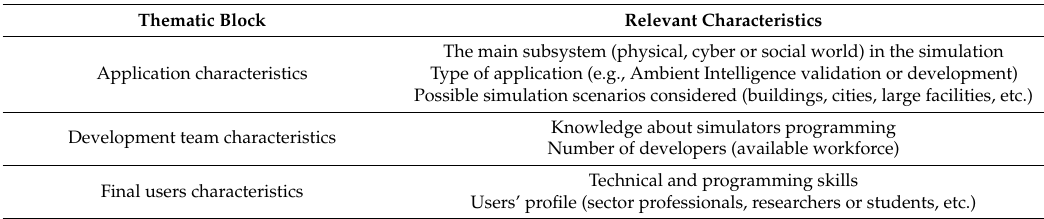
Table 5. Relevant characteristic for a co-simulator.